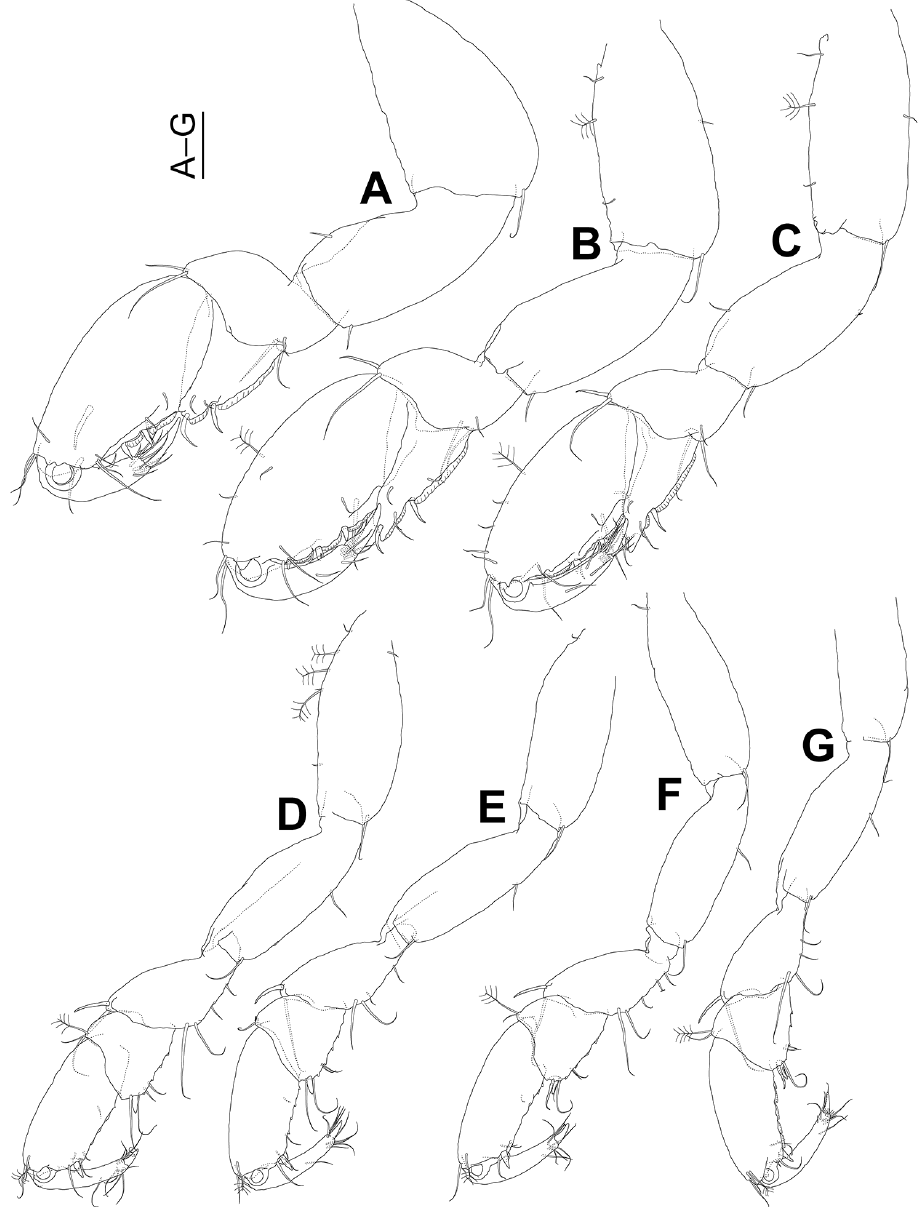
Figure 3. Kupellonura tamago sp. nov., holotype, female. A – G , left pereopods 1–7. Scale bar: 100